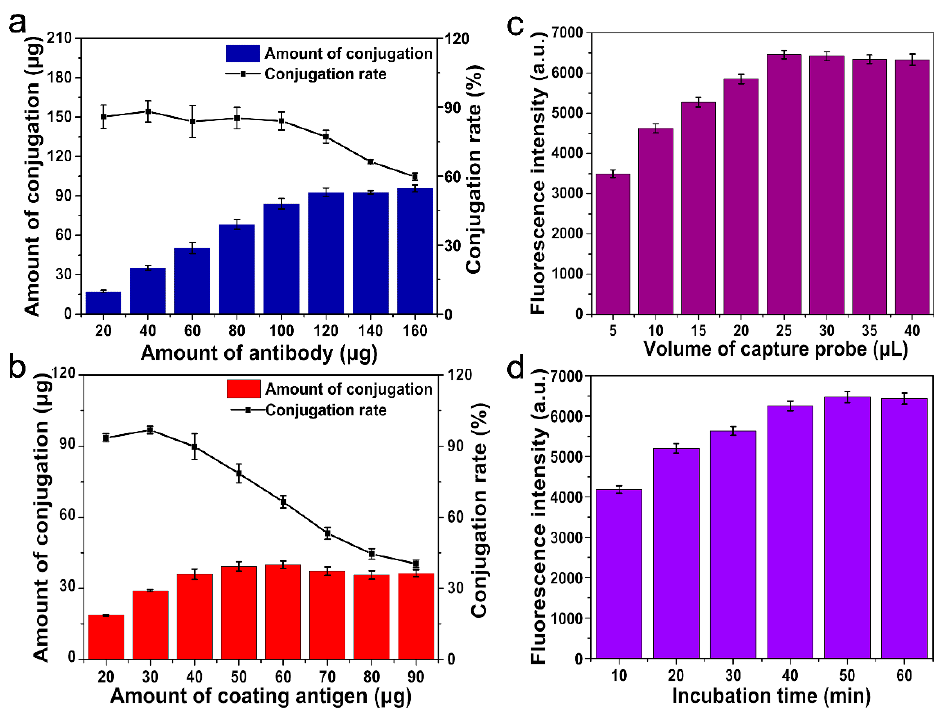
Figure 4. Optimization of the working parameters. ( a ): Optimization of the anti-IQ antibody amount in signal probe, ( b ): Optimization of the coating antigen amount in capture probe, ( c ): Optimization of the added volume of the capture probe in test process with 25 µ L of the signal probe, ( d ): Optimization of the incubation time of the signal probe, capture probe and sample solution. Each value is mean of three replicates.